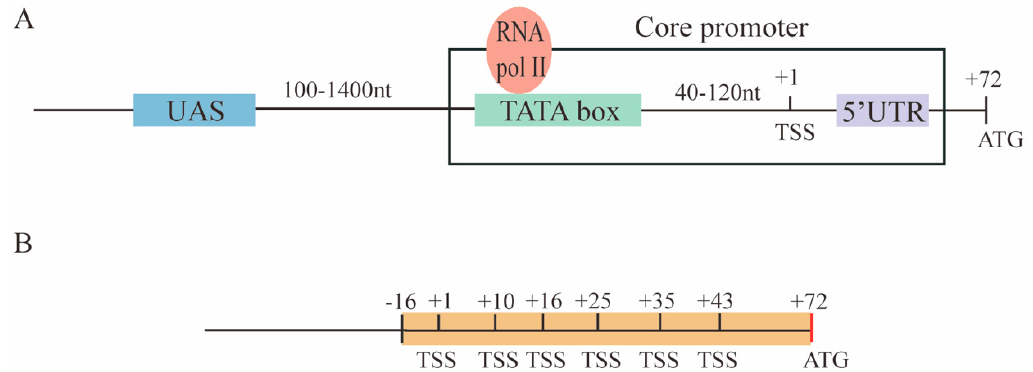
Figure 1. Promoters in S. cerevisiae . ( A ) The structure of promoters in the baker’s yeast is characterized by four main elements: The upstream activating sequence (UAS), the TATA box (where RNA polymerase II—RNA pol II—binds), the transcription start site (TSS), and the 5 ′ UTR (untranslated region). The core promoter sequence consists of the TATA box(es), the TSS(s), and the 5 ′ UTR. ( B ) The pCYC1noTATA begins at position − 16 with respect to the TSS at position +1 in the CYC1 yeast promoter. It contains six TSSs over 43 of the 71 nucleotides that constitute the CYC1 promoter 5 ′ UTR.